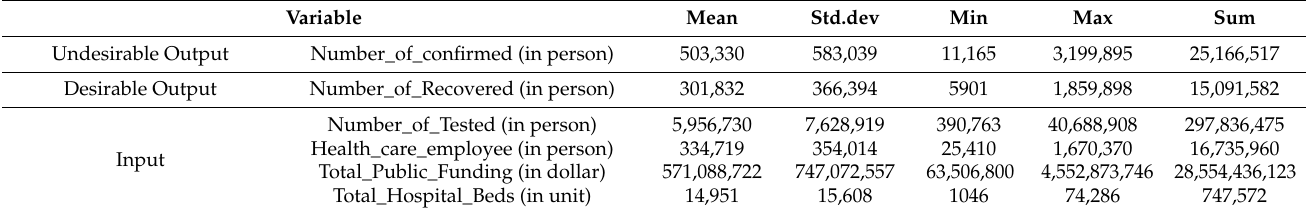
Table 4. Descriptive Statistics of the Dataset used in DEA.